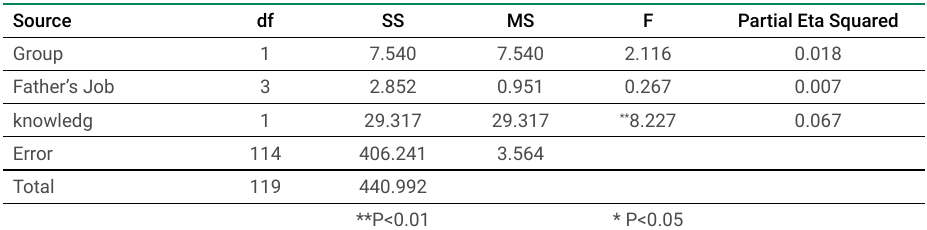
Table 2. Analysis of Covariance for the Effect of education on knowledge Source df